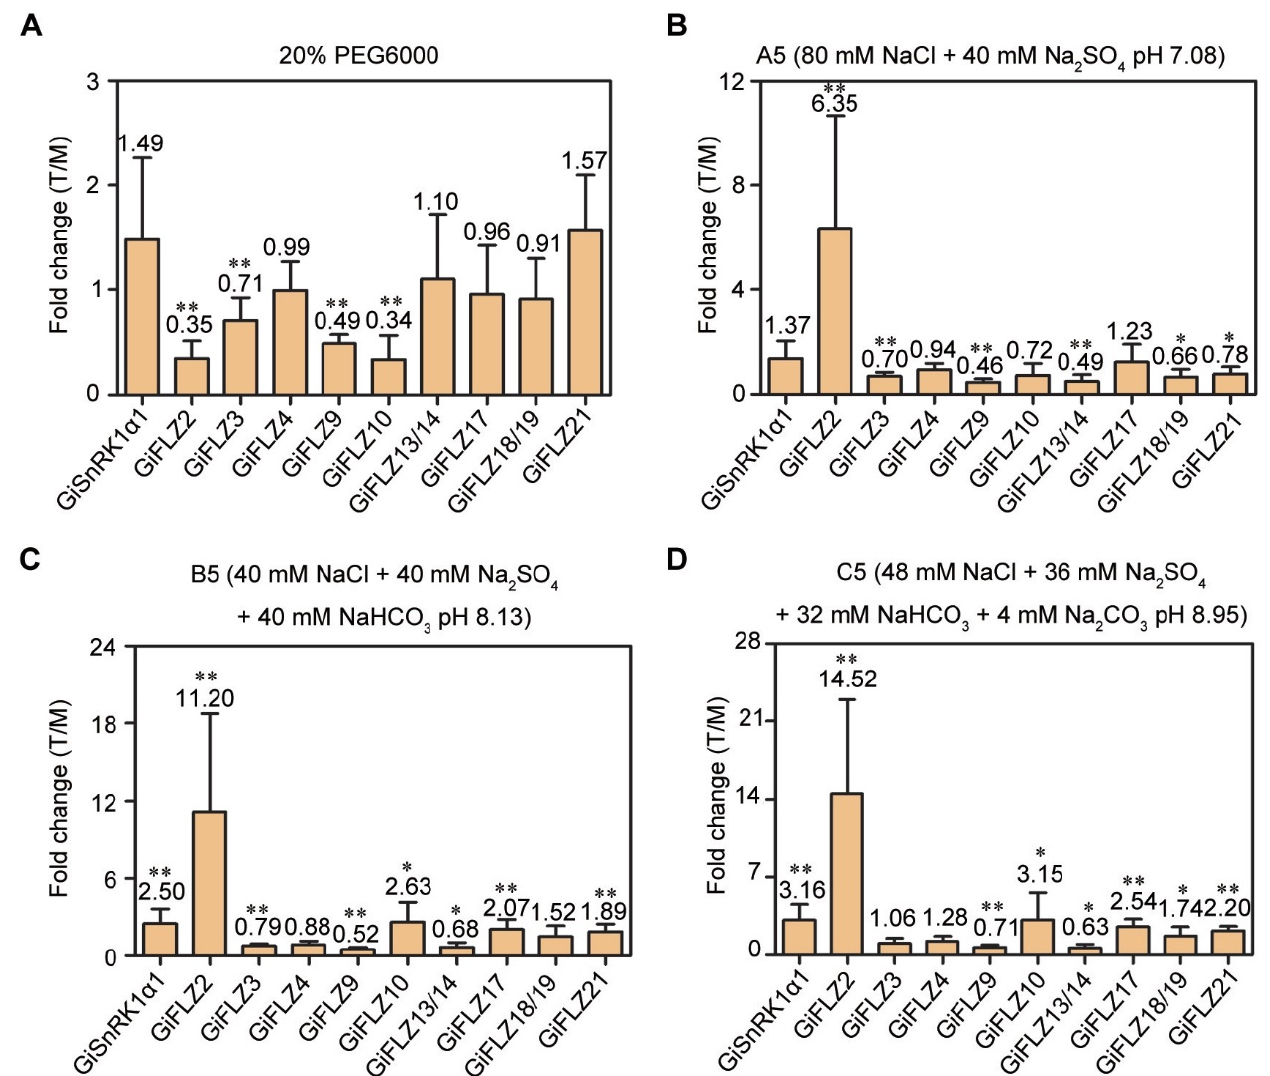
Figure 6. Expression pattern of selected GiSnRK1 α and GiFLZ genes in abiotic stress treatments. The qRT-PCR data were assayed for the expression of selected GiSnRK1 α and GiFLZ genes in the roots of 5-day-old seedlings subjected to 20% PEG6000 ( A ), A5 ( B ), B5 ( C ), and C5 ( D ) treatment for 2 h. The fold change of treatment (T) in relation to mock (M) are presented as mean ± SD ( n = 9), and the data on the graph indicate the ratios. * p < 0.05; ** p < 0.01—determined by Student’s t-test.